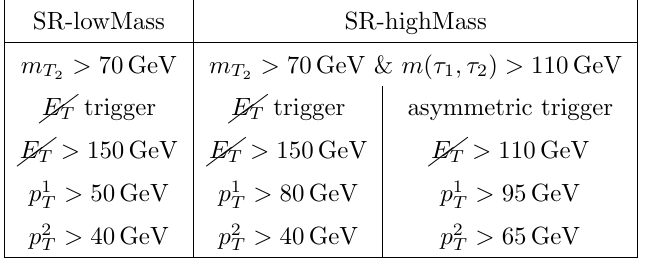
Table 1 . Signal regions used in the di-tau analysis.